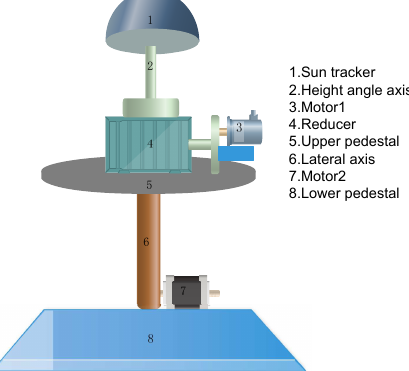
Figure 3. Model of automatic rotary alignment device based on angle perception of sun